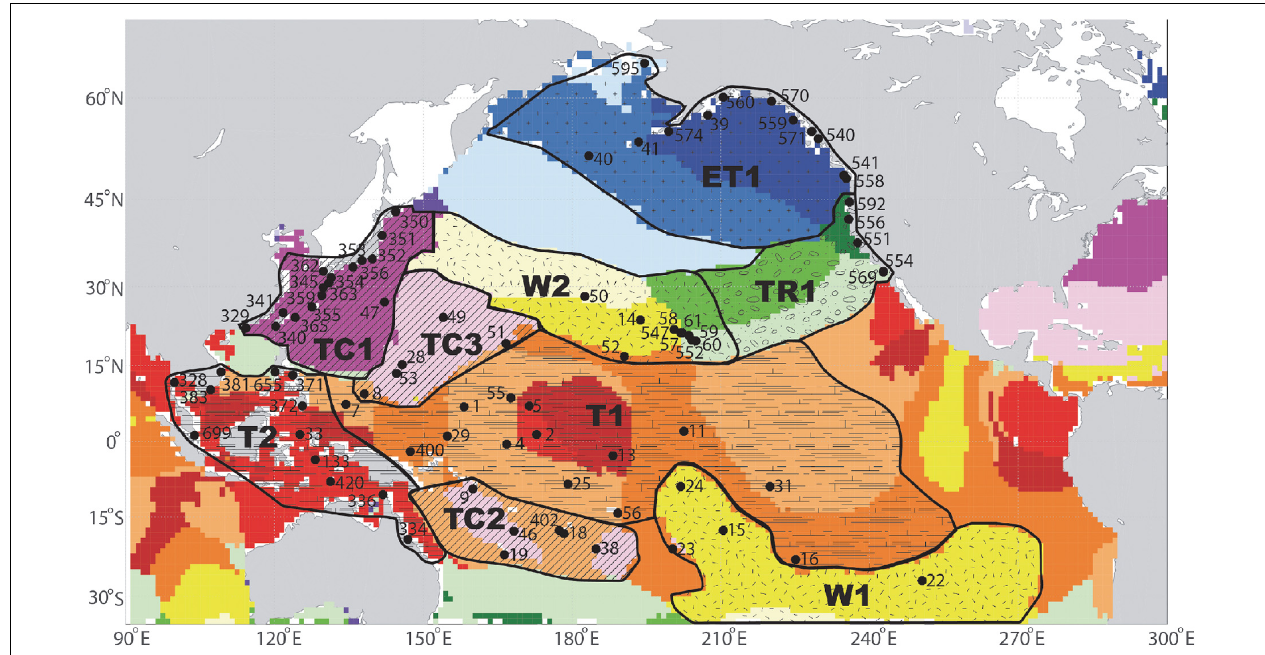
FIGURE 2 | TGs with the University of Hawaii Sea Level Center numbering designation and the RFA homogeneous Tide-dominated (T), Tropical Cyclone (TC), Extratropical (ET), Wave-dominated (W), and Transition (TR) regions delineated in this study based upon the color-shaded classifications of Rueda et al. (2017). The Rueda et al. (2017) shape-file classifications were shared by the authors as licensed under CC BY 4.0.